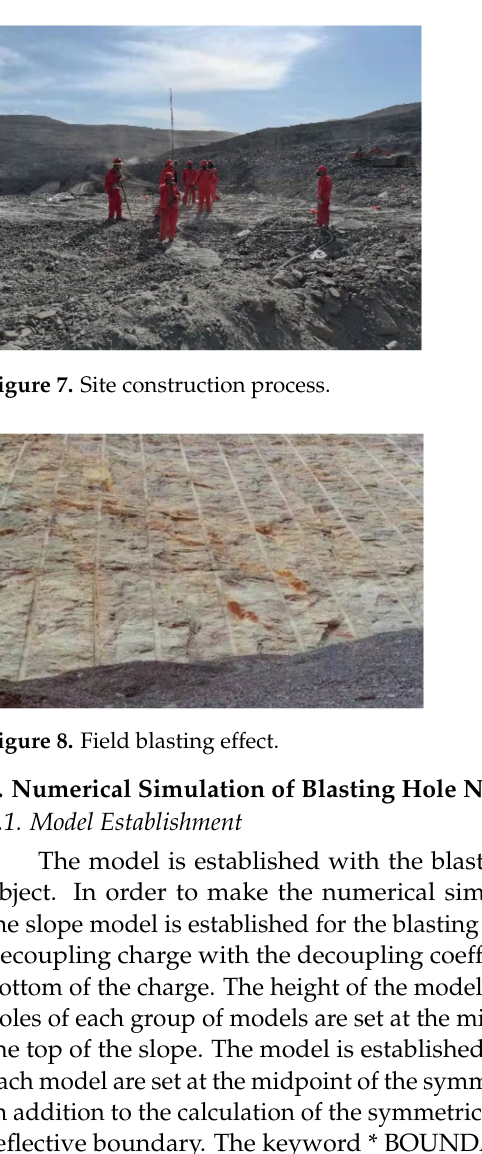
Figure 6. Chart of charge structure of each hole.